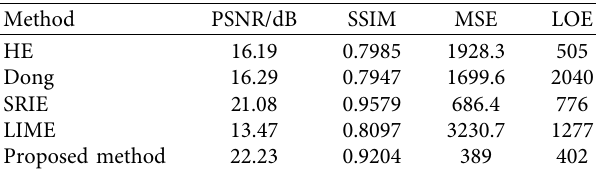
Table 1: Test PSNR values under different network layers and convolution